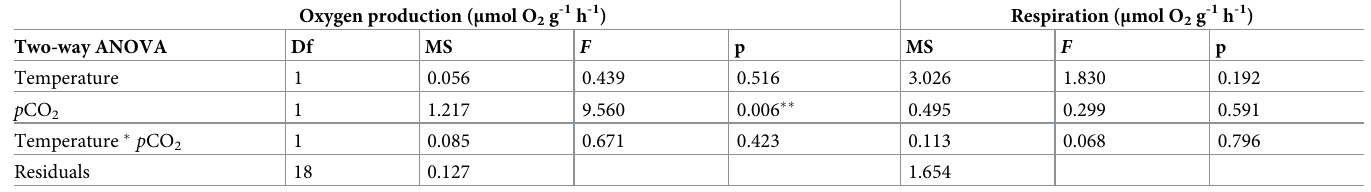
Table 3. Results of two-way ANOVA for the effects of temperature and p CO 2 (pH) on the metabolic rates of adult fragments of Sporolithon after 5 months in